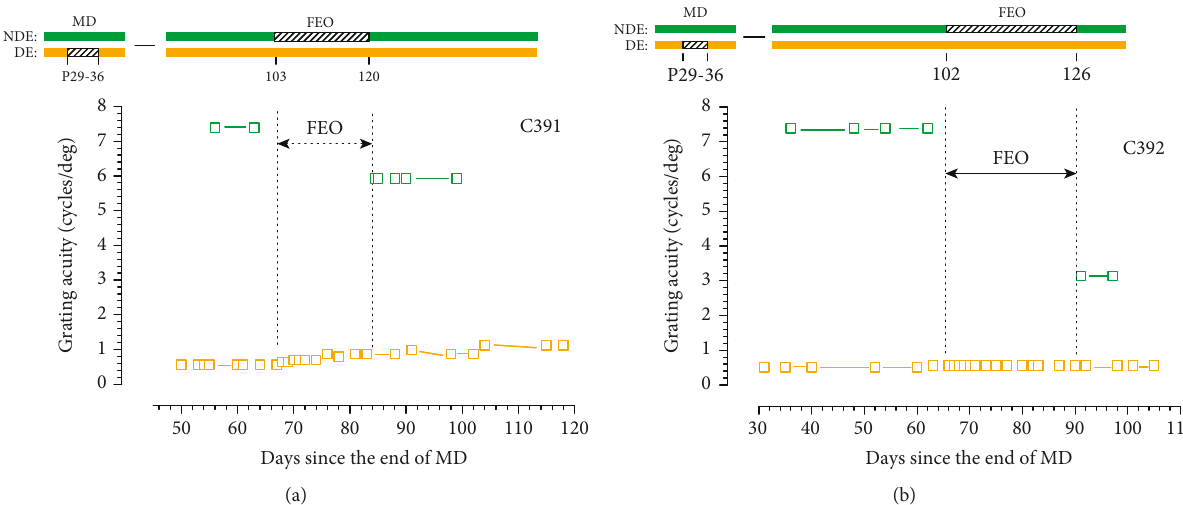
Figure 2: The grating acuity of the deprived eye (orange symbols) and the binocular acuity (green symbols) of 2 monocularly deprived littermate kittens prior to and following 17 (a) (C391) or 24 (b) (C392) days of fellow eye occlusion (FEO). The visual histories of the two animals are depicted above the two graphs.